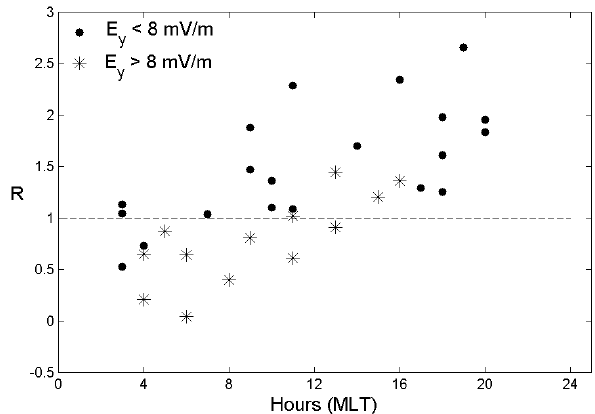
Fig. 2. The MLT dependence of the R ratio sorting the intervals according to the SW electric field.